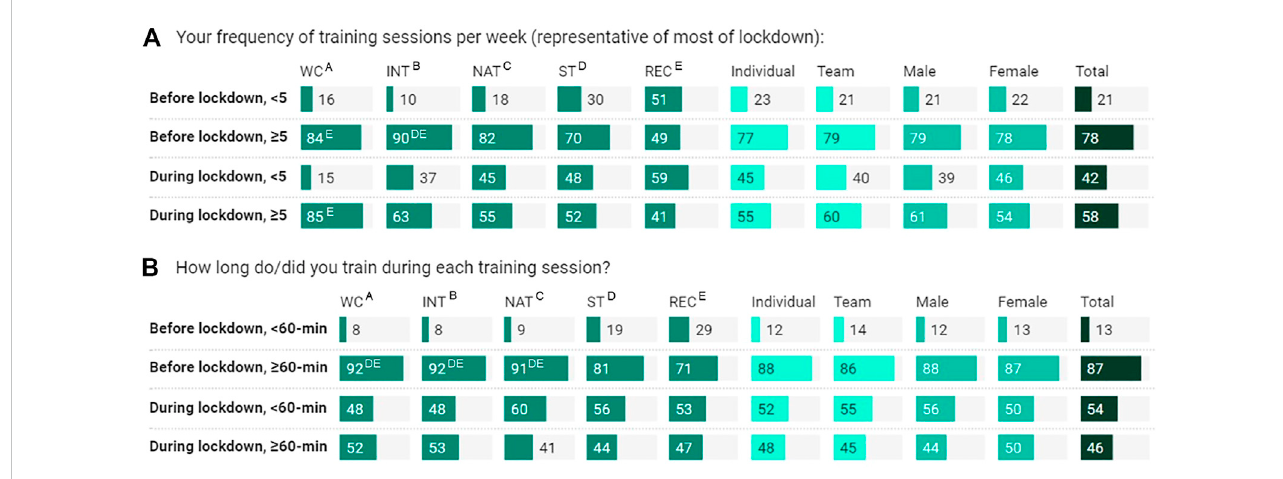
FIGURE 3 Training frequency ( < or ≥ 5 sessions/week; (A) ) and duration ( < or ≥ 60 min/session (B) ) based on athlete classi fi cation, sport-type, gender, and total cohort, beforeandduring lockdown;data arecolumn %ofrespondents( n =661).Percentage,within athleteclassi fi cation, sport-type,and genderrepresents “ yes ” answer, relative to “ no ” answer. WC, world-class; INT, international; NAT, national; ST, state; REC, recreational. *Signi fi cantly higher (or signi fi cant contributor to the relationship); superscript letter represents signi fi cantly higher than A/B/C/D/E ; all at p < .05, based on residuals of > 1.96.